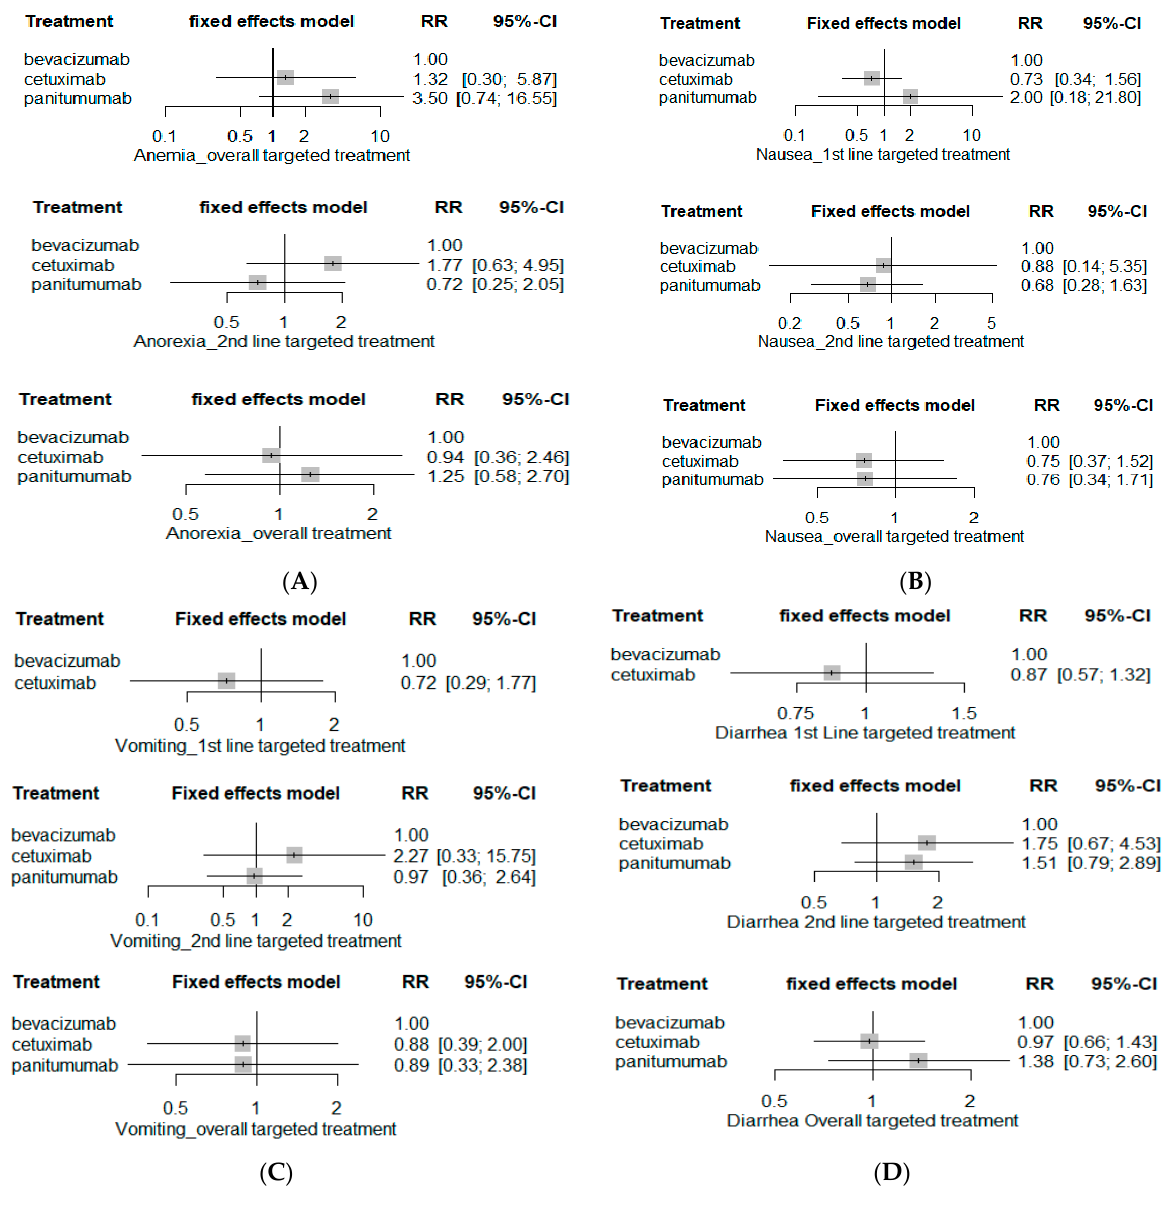
Figure 5. GI SAE risks. ( A ) Anorexia; ( B ) nausea; ( C ) vomiting; and ( D ) diarrhea.